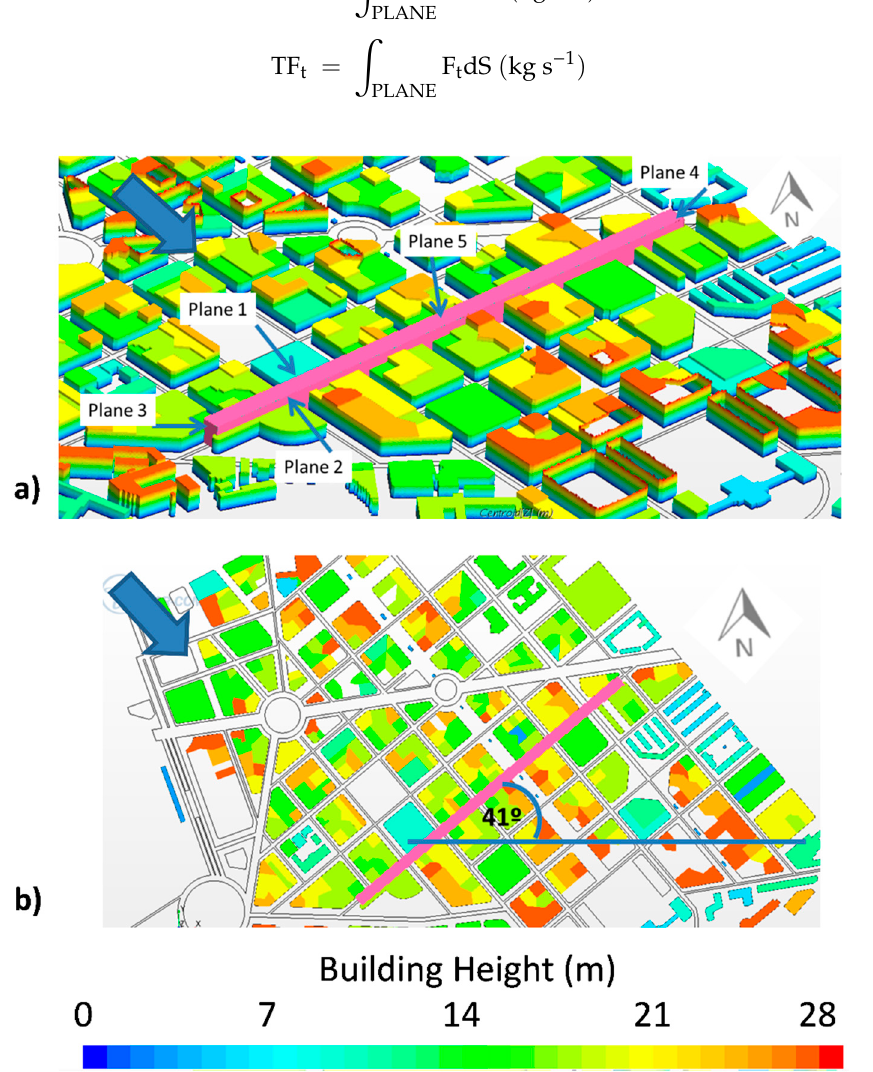
Figure 2. ( a ) Planes used for street ventilation assessment of the study street. ( b ) Indication of the study street orientation (right), where the blue arrow indicates the prevailing wind direction.